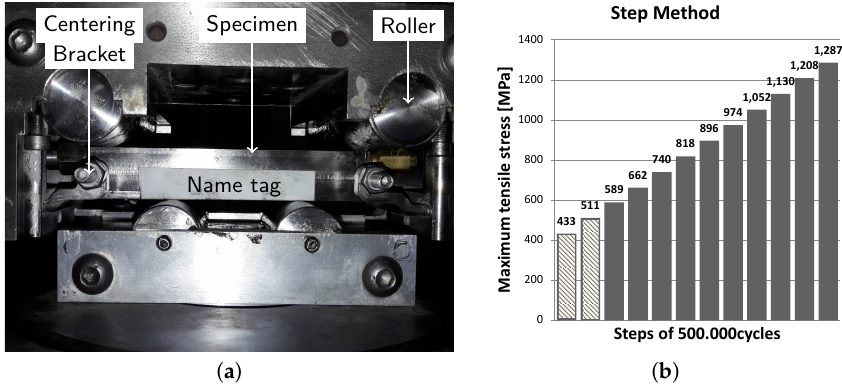
Figure 3. All specimens were subjected to four-point bending fatigue tests according to the step method. ( a ) specimen installed in the four-point bending test setup and ( b ) the maximum tensile stress levels in each load